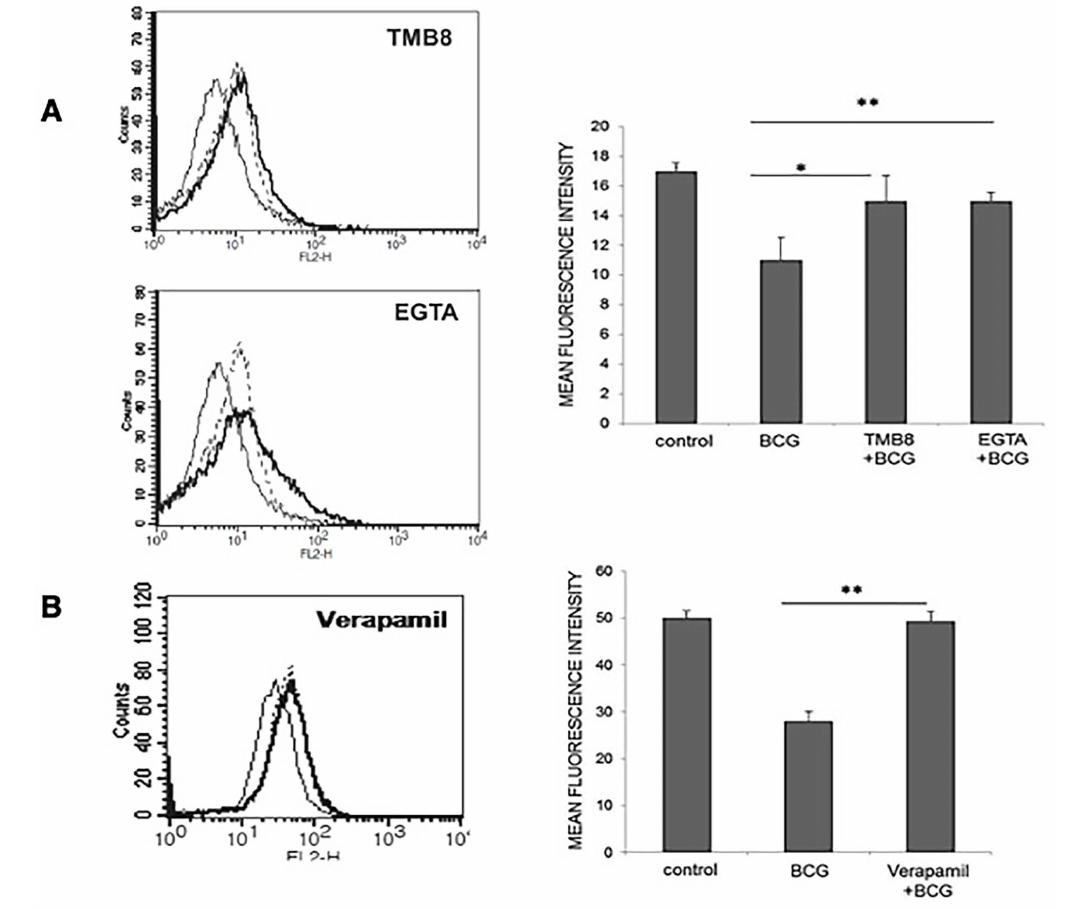
Figure 4: Calcium homeostasis regulates M. bovis BCG mediated IFN-γR expression on macrophages. THP-1 derived macrophages were treated with specific bio-pharmacological inhibitors to (A) calcium influx from external medium (EGTA, 3mM) and calcium release from intracellular stores (TMB8, 100µM) or (B) voltage gated calcium channels (Verapamil, 20µM) for 1h prior to infection with M. bovis BCG at 2MOI for 24h. IFN-γR levels were monitored by flow cytometry. In all the panels, dotted lines represent receptor levels in control groups, thin lines represent receptor levels in BCG infected groups and bold black lines represent receptor levels in specific inhibitor treated infected groups. *p<0.05 and **p<0.01, using one-way ANOVA with Tukey’s correction to calculate statistical significance between different groups. Data are represented as mean fluorescence intensities and expressed as mean ± S.D. (n=3). While inhibiting calcium influx from external medium brought back the down-modulated IFN-γR to levels comparable with uninfected cells at